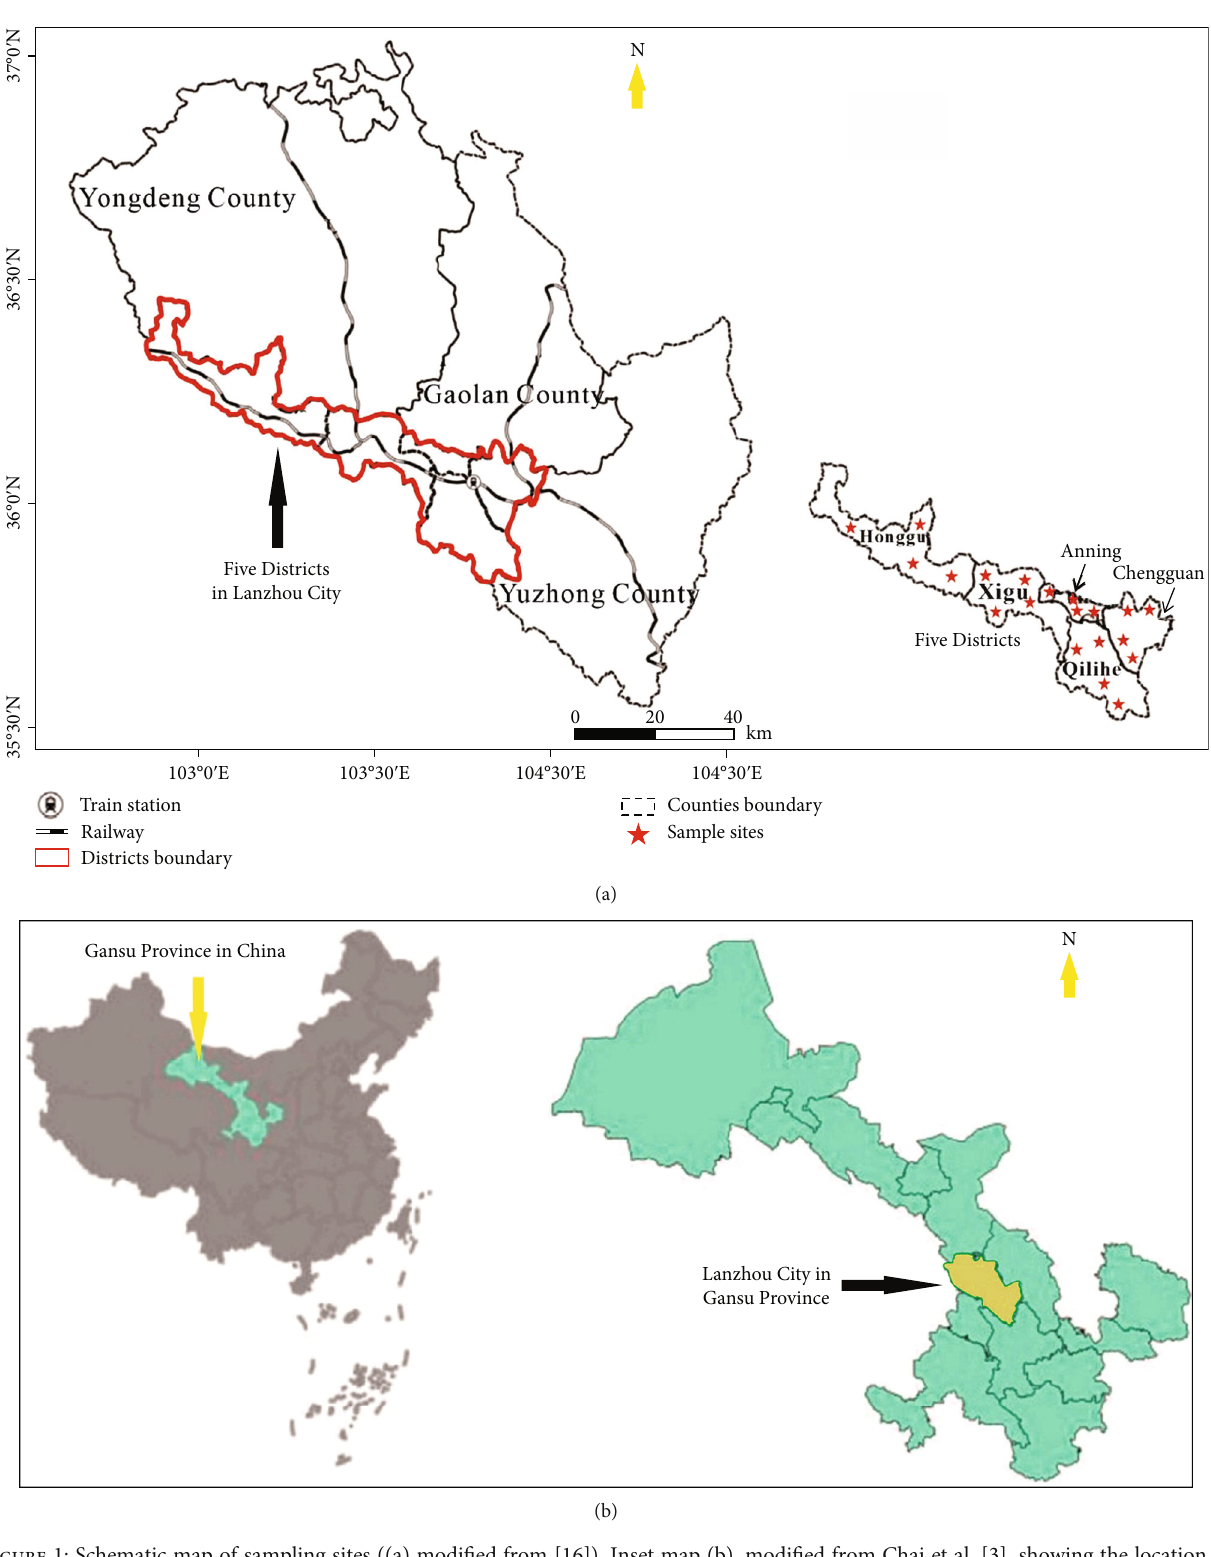
Figure 1: Schematic map of sampling sites ((a) modi fi ed from [16]). Inset map (b), modi fi ed from Chai et al. [3], showing the location of Lanzhou city in Gansu Province,